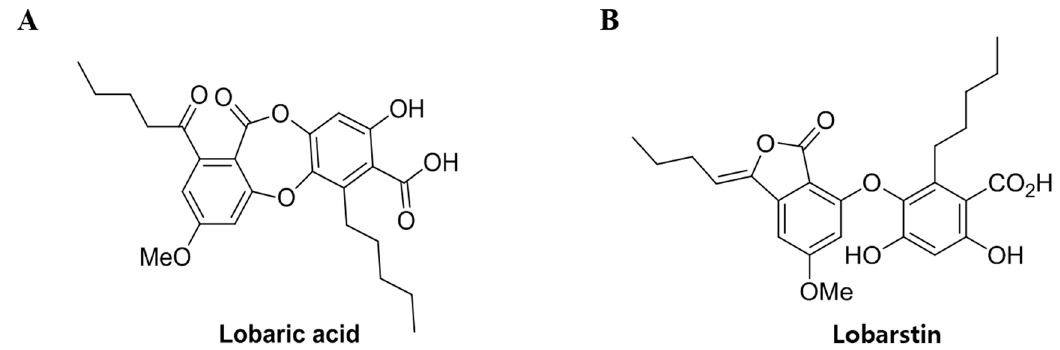
Figure 1. Chemical structure of ( A ) lobaric acid (molecular weight [Mw], 456.49) and ( B ) lobarstin (Mw.